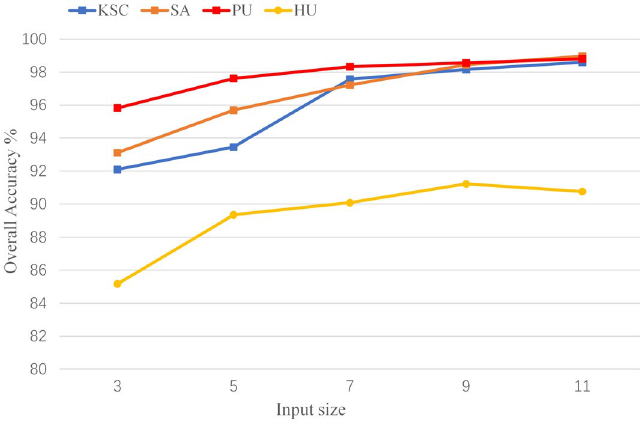
Figure 11. OA (%) of DBFFT with different input size in the four